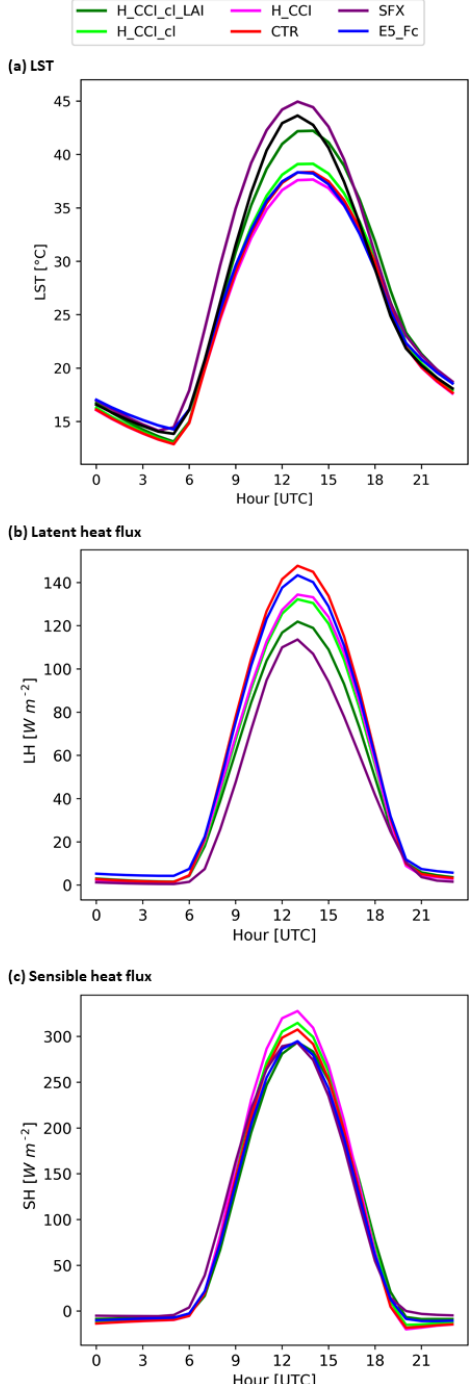
Figure 7. Diurnal cycles of JJA (a) LST, (b) latent heat flux, and (c) sensible heat flux averaged over all Iberia grid points, computed from LSA-SAF (black), ERA5 (blue), SFX (purple), CTR (red), H_CCI (pink), H_CCI_cl (light green), and H_CCI_cl_LAI (dark green). Only time instants under clear-sky conditions were consid-